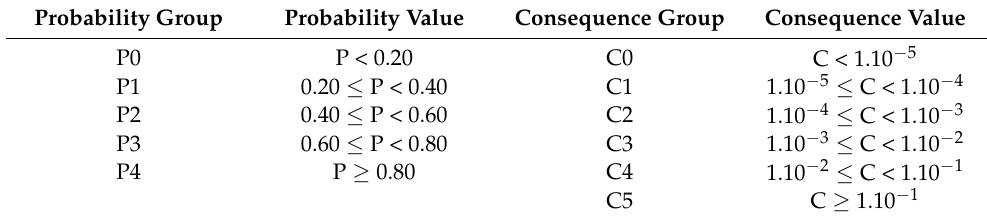
Table 4. Classification of P and C values applied in the study.